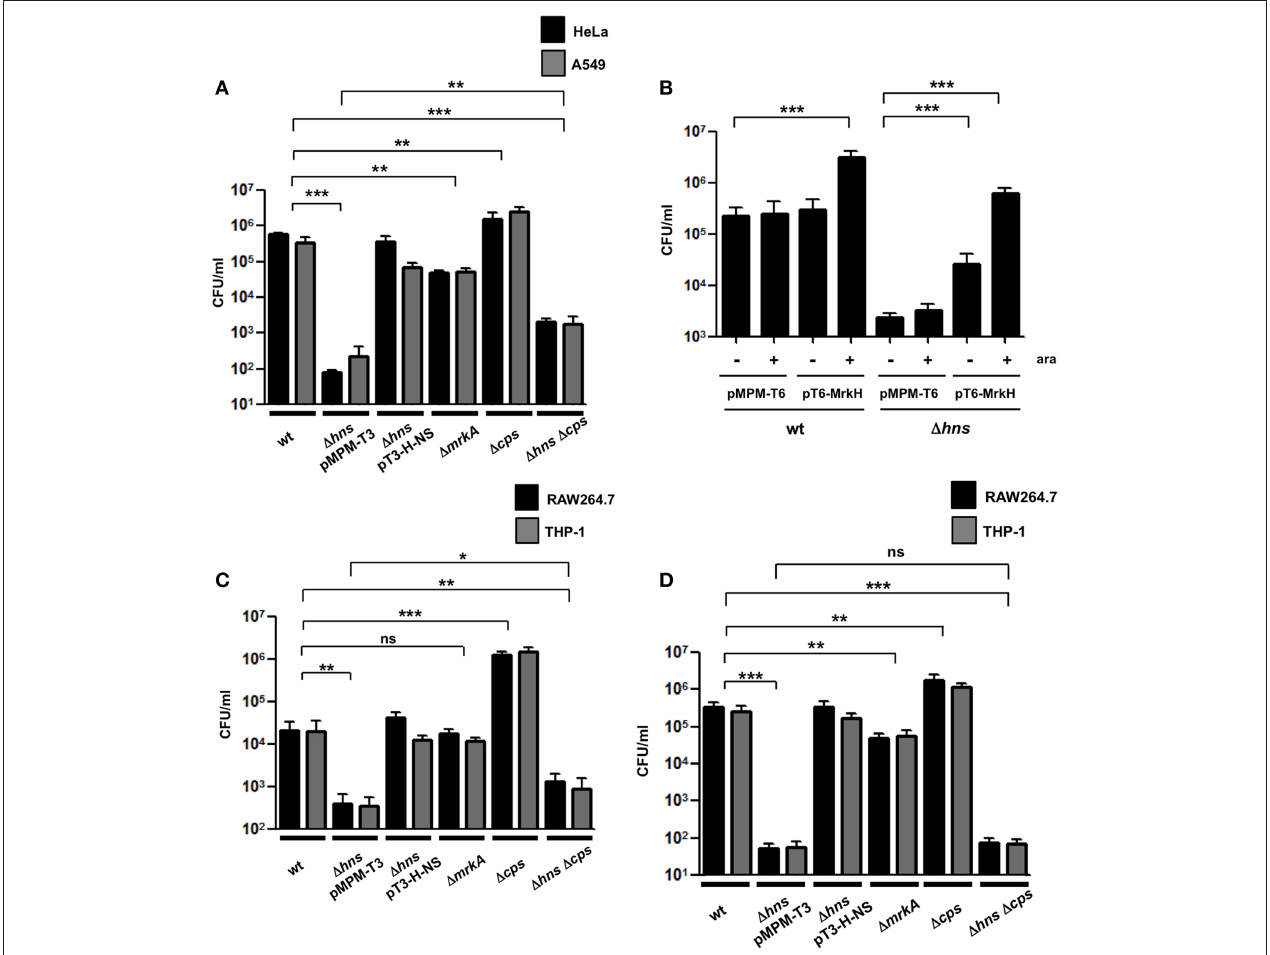
FIGURE 5 | Adherence and phagocytosis of the K. pneumoniae 1 hns mutant. (A) Comparison of adherence levels of K. pneumoniae wild-type, 1 hns mutant, complemented 1 hns mutant, 1 mrkA mutant, 1 cps mutant, and 1 hns 1 cps mutant to HeLa and A549 cells. (B) Adherence levels of wild-type strain and isogenic 1 hns mutant to HeLa cells, overexpressing the MrkH activator protein (0.1% arabinose). (C) Comparison of phagocytic uptake of indicated K. pneumoniae strains by RAW264.7 and THP-1 macrophages. (D) Adherence levels of K. pneumoniae wild-type strain and isogenic mutants to RAW264.7 and THP-1 macrophages. Results represent means and standard deviations of the results obtained from the 3 experiments performed in triplicates. ns, not significant; statistically significant with respect to the wild-type strain *** p < 0.001 ; ** p < 0.01 ; * p < 0.05